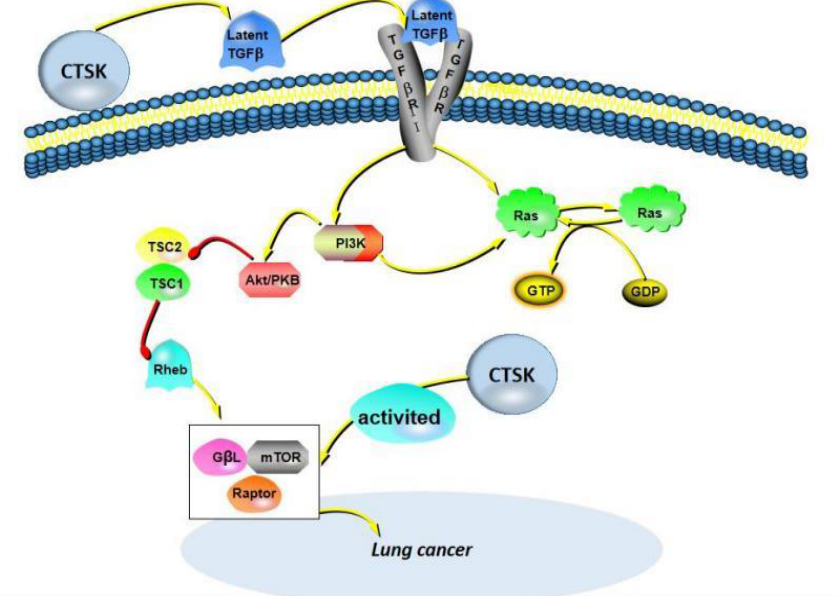
Figure 5. A partial mechanism of action of CTSK in lung cancer. Two pathways of CTSK expression are elucidated: first, transforming growth factor- β (TGF- β) acts as an efficient substrate for CTSK to activate the PI3K and Ras proteins. Second, CTSK is expressed by directly activating the mTOR signaling pathway, mainly the mTORC1 complex.